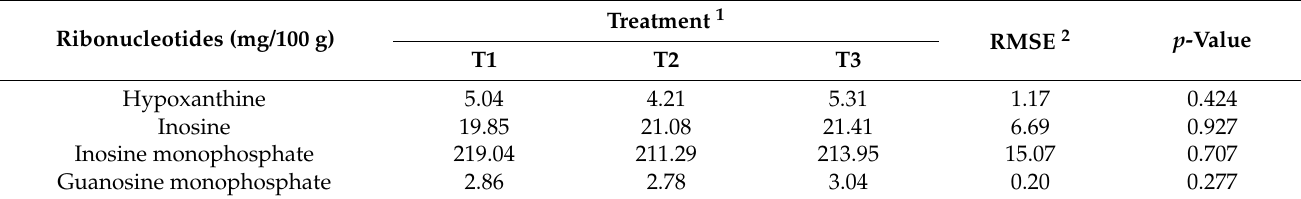
Table 5. Effect of dietary-energy-density treatment (T) 1 on ribonucleotide content of Longissimus thoracis muscle of native Thai cattle aged for 2